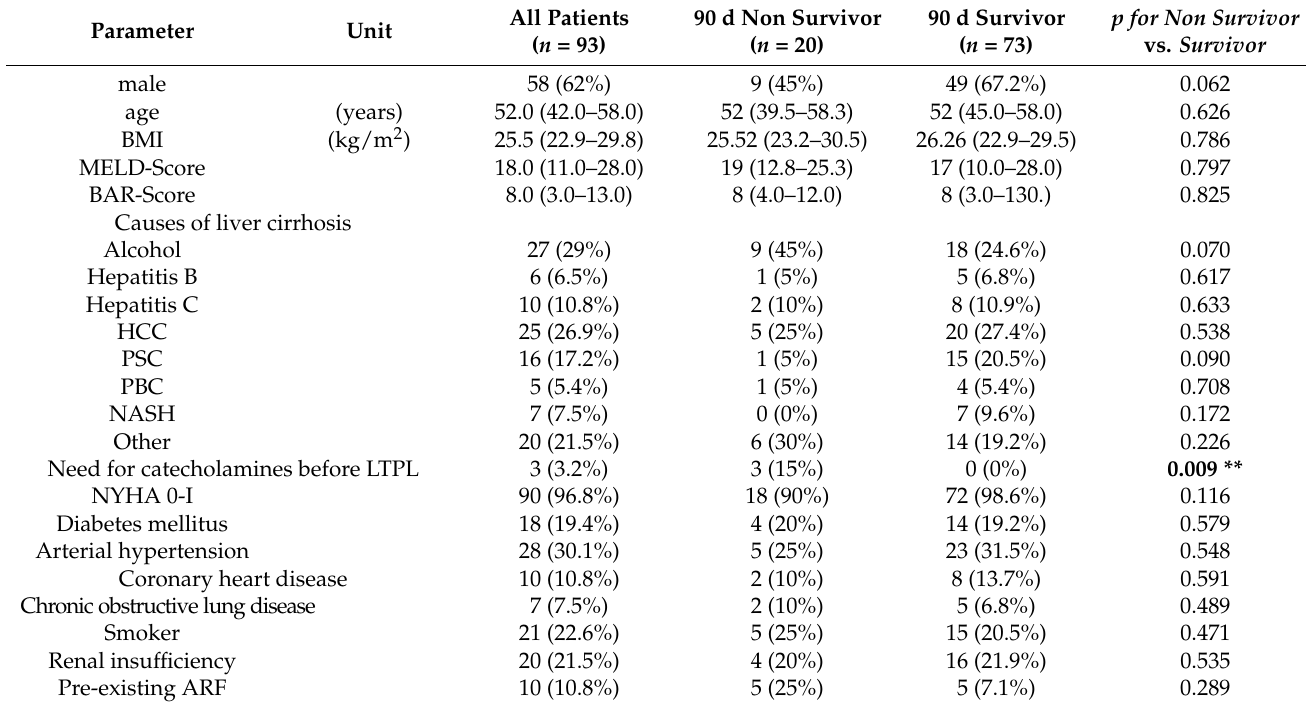
Table 1. Patients’